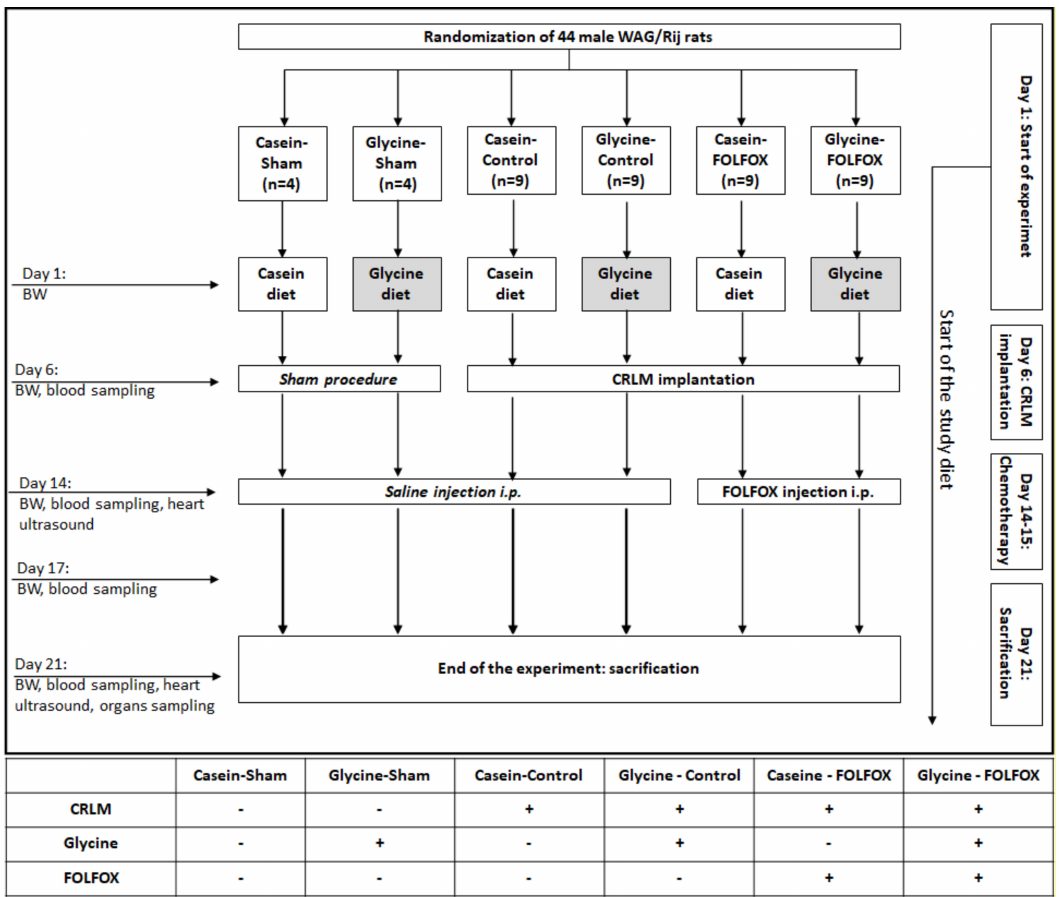
Figure 1. Flowchart of the animal experiment. FOLFOX—chemotherapy regimen containing calcium folinate, oxaliplatin, and 5-fluorouracil; BW—body weight; CRLM—colorectal cancer liver metastasis; i.p.